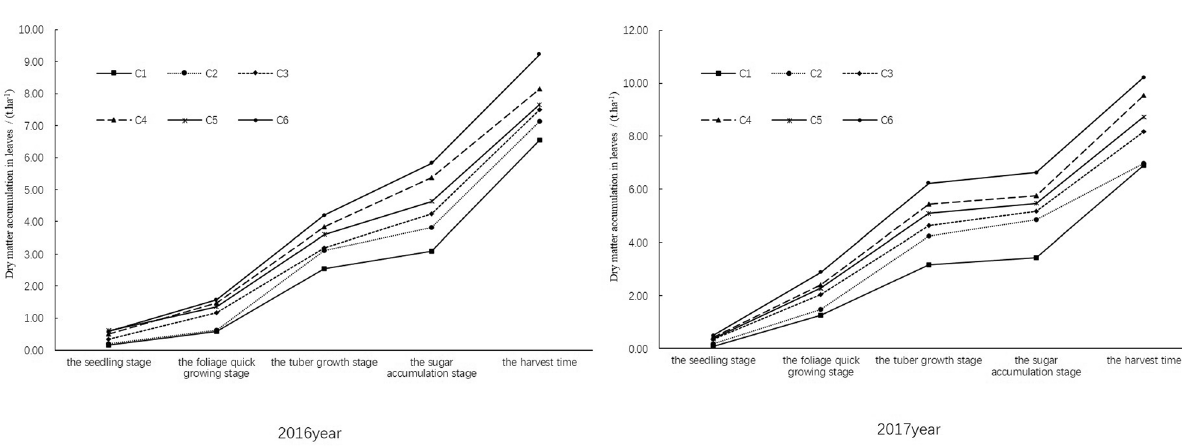
Figure 4. Effect of limited irrigation on dry matter accumulation in the leaves of sugar beet in 2016 and